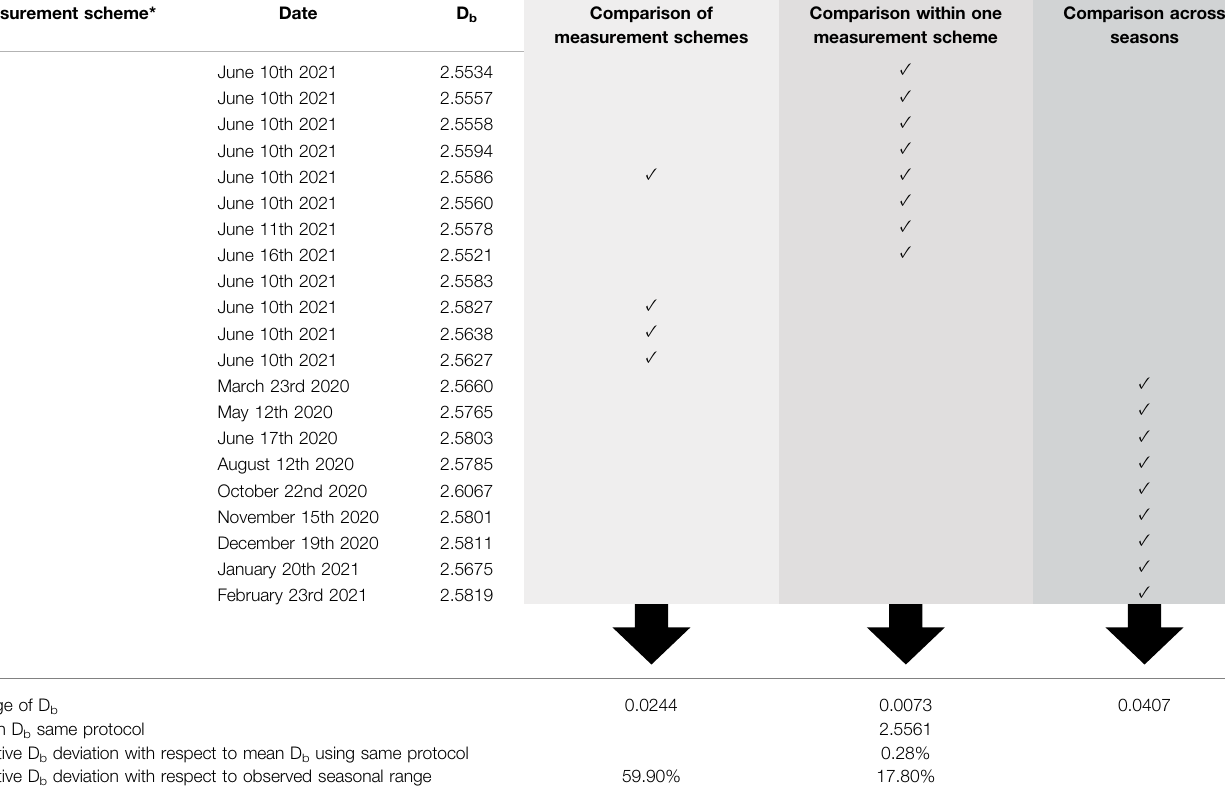
Comparison of Comparison within one Comparison across measurement schemes measurement scheme